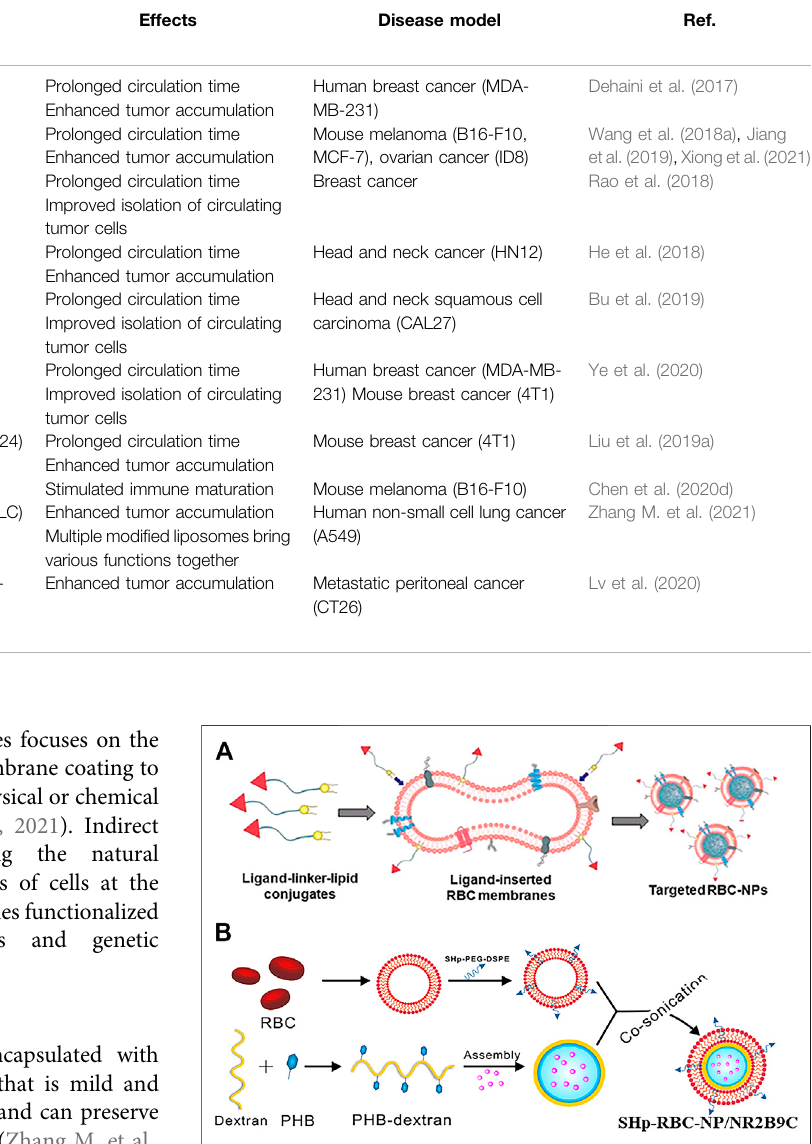
FIGURE 3 | (A) Schematic of the preparation of targeted RBC-NPs (Reproduced with permission from Fang et al. (2013)). (B) Schematic of the preparation of SHp-RBC-NP/NR2B9C (Reproduced with permission from Lv et al.